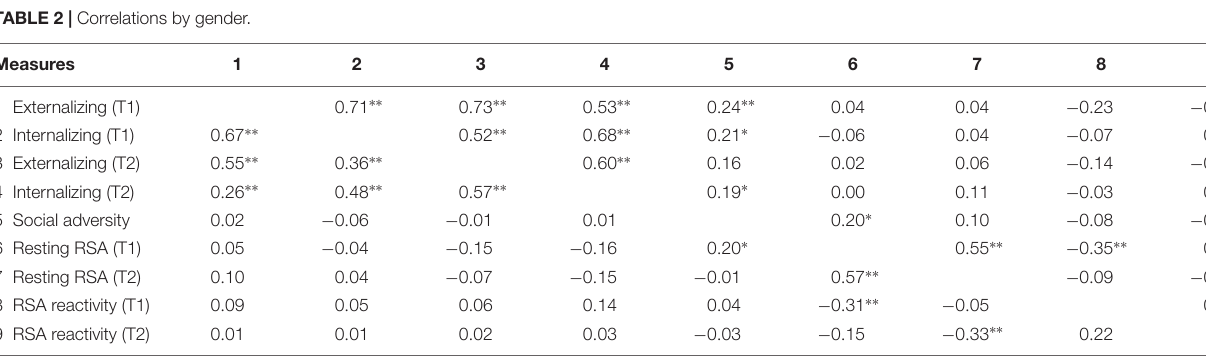
TABLE 2 | Correlations by